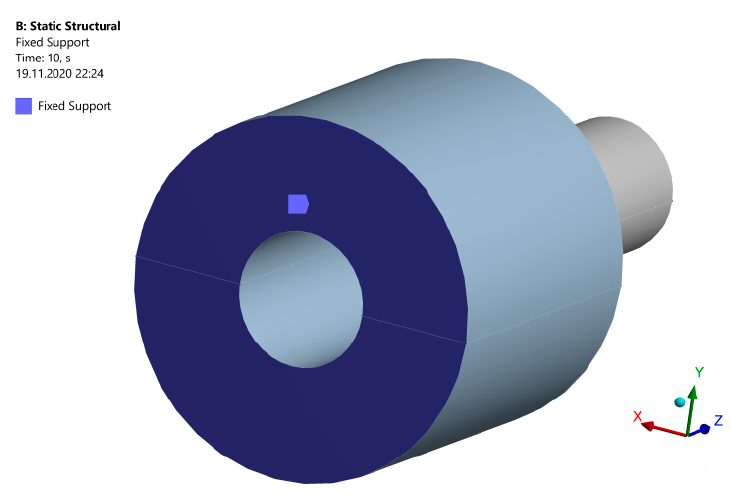
Figure 4. Fixed area.